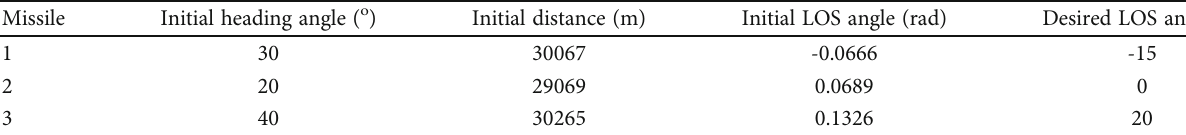
Table 1: Initial conditions for three missiles.